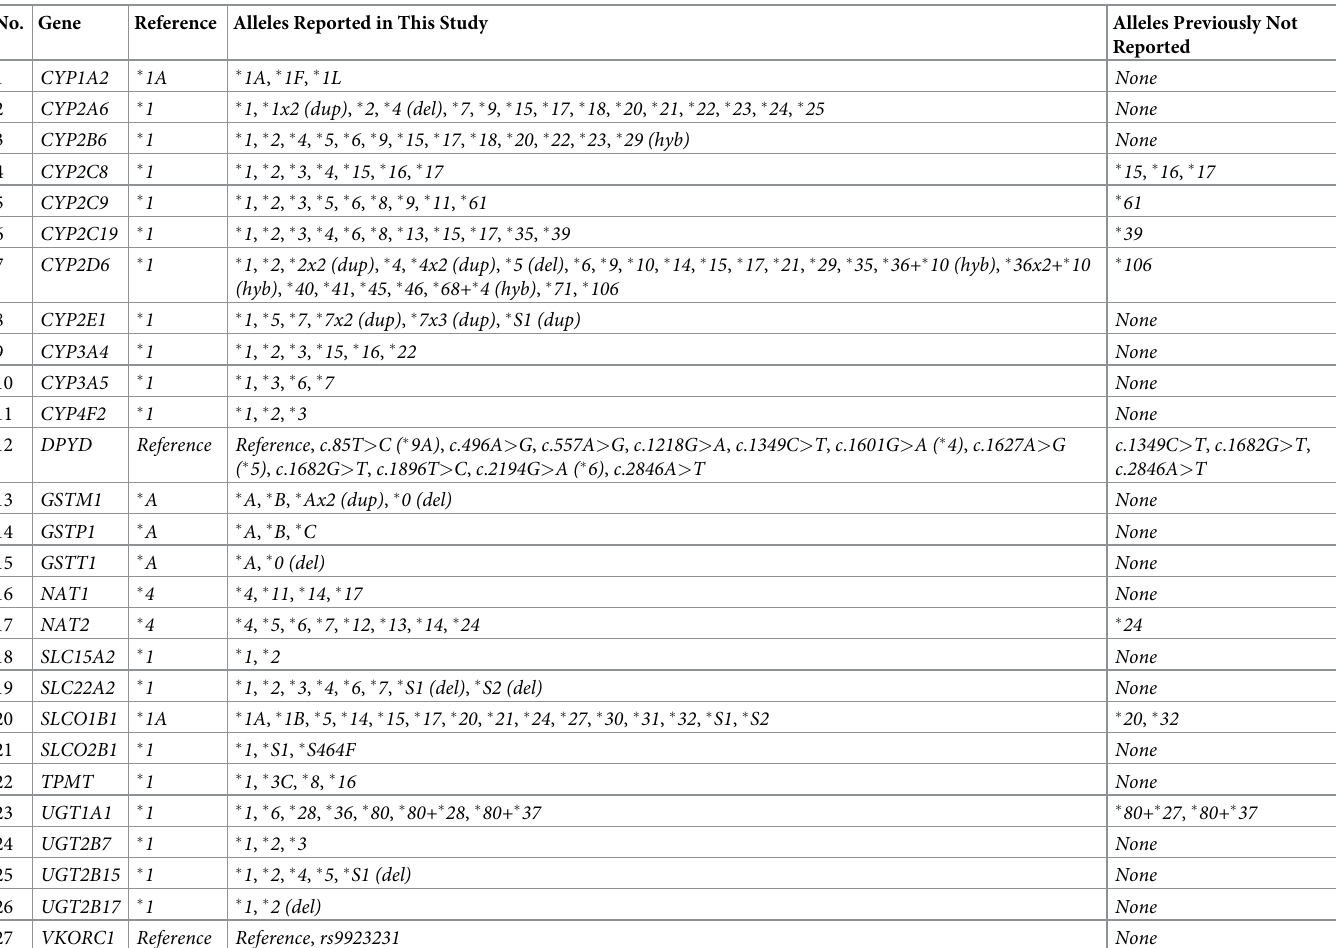
Structural variant-defined alleles are indicated by ‘del’ (deletion), ‘dup’ (duplication), and ‘hyb’ (hybrid). https://doi.org/10.1371/journal.pone.0272129.t002 duplications (e.g. CYP2A6 � 1x2 ), multiplications (e.g. CYP2E1 � 7x3 ), and hybrids (e.g. CYP2D6 � 36+ � 10 ); these were collectively found in 10.4% (177/1,701) and 10.2% (192/1,890) of the diplotypes examined, respectively. As expected, a large proportion of the diplotypes from the genes CYP2A6 , GSTM1 , GSTT1 , and UGT2B17 had whole gene deletions, both heterozy- gous and homozygous (e.g. UGT2B17 � 1/ � 2 and � 2/ � 2 ). For example, we found the gene dele- tion alleles GSTM1 � 0 and GSTT1 � 0 in 76.2 (48/63) and 77.8% (49/63) of the samples with ClinPharmSeq and 75.7 (53/70) and 77.1% (54/70) of the samples with WGS, respectively. Importantly, ClinPharmSeq and WGS showed a perfect concordance on all the SV alleles, indicating that ClinPharmSeq can reliably detect SVs despite it being a targeted capture panel (S2 Table). Three representative examples of SV detection ( CYP2B6 � 29 , CYP2A6 � 1x2 , and CYP2D6 � 36x2+ � 10 ) by PyPGx using the ClinPharmSeq and WGS data are illustrated in Fig 4. Of note, ClinPharmSeq correctly identified the CYP2B6 � 29 allele, a CYP2B7/CYP2B6 hybrid, even though the probes only covered less than half of the region. We discovered that four of the diplotypes from previous publications differed with the calls from both ClinPharmSeq and WGS because of SV detection and/or interpretation. In the first